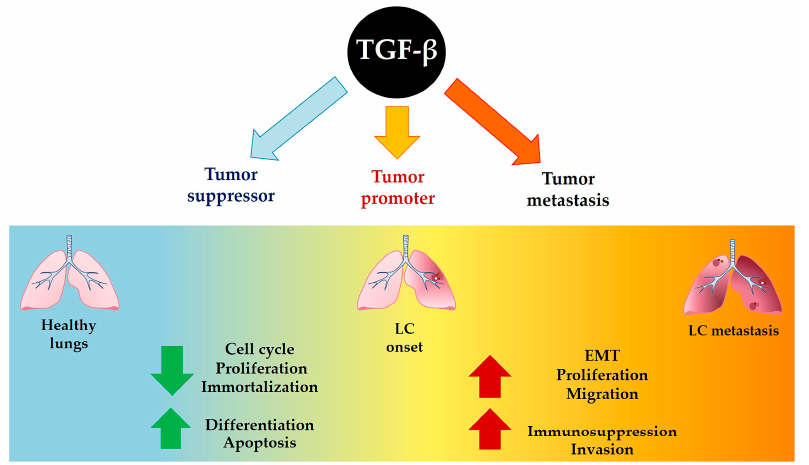
Figure 1. TGF- β functions in LC development and metastasis.